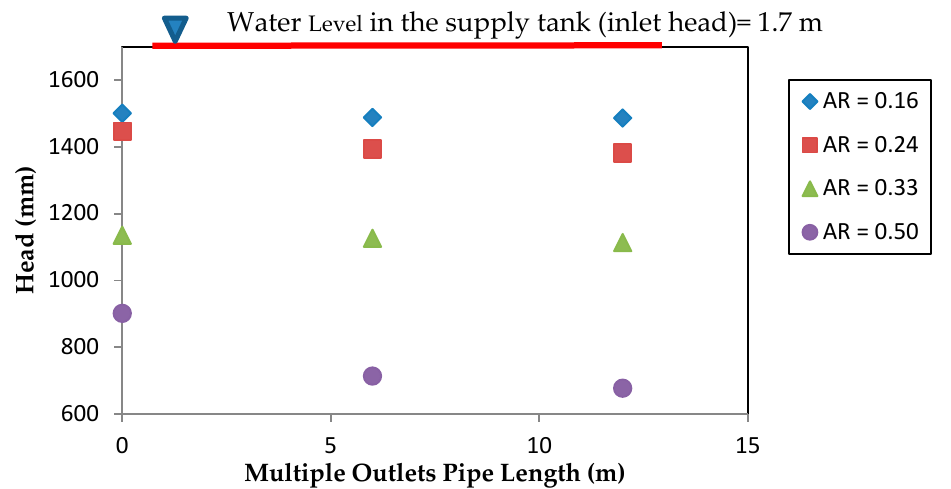
Figure 5. Variation of the pressure head for various area ratios (inlet head = 1.7 m, spacing = 6.0 m).